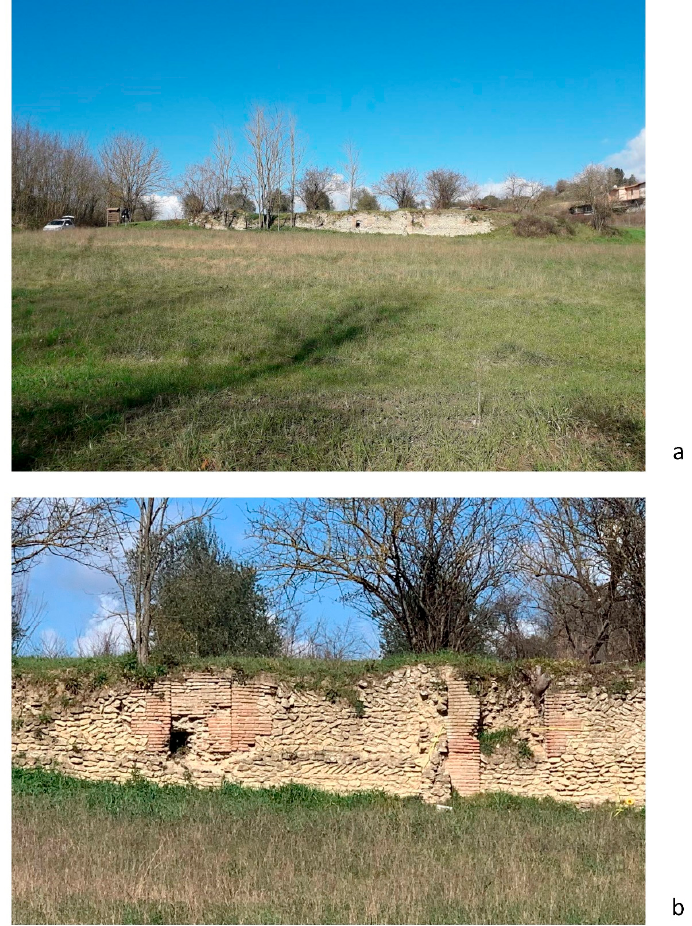
Figure 2. ( a ) The remains of the south-facing ancient wall lining the olive grove. ( b ) A detailed view of the coursing. This wall defines the south-east side of a modern olive grove and some lightly ploughed fields. These fields produced ancient bricks, tiles, coins, well-preserved mosaic tesserae , and ceramics during the late Republican and early Imperial periods [27,28]. A few fragments are still easily visible to the naked eye. As it is located near the left bank of the Tiber river, it is likely to have been part of a